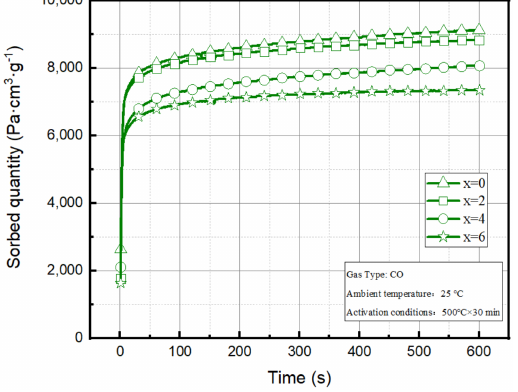
Figure 2. CO absorption curves of coated